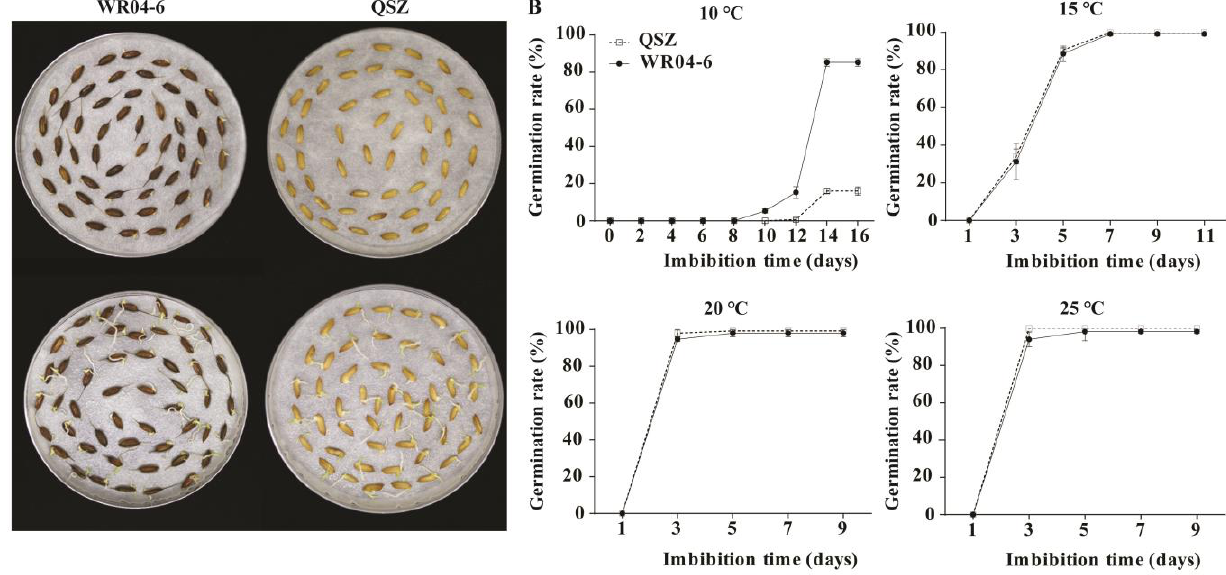
Figure 1. Low-temperature germinability of WR04-6 and QSZ. ( A ) Germination phenotype of WR04-6 and QSZ at 25 °C for 3 DAI and at 10 °C for 14 DAI. ( B ) Time course of germination rates at different temperatures. The modest square is QSZ. The solid circle is WR04-6. Three biological repeats were conducted. Error bars represent SD ( n = 3).